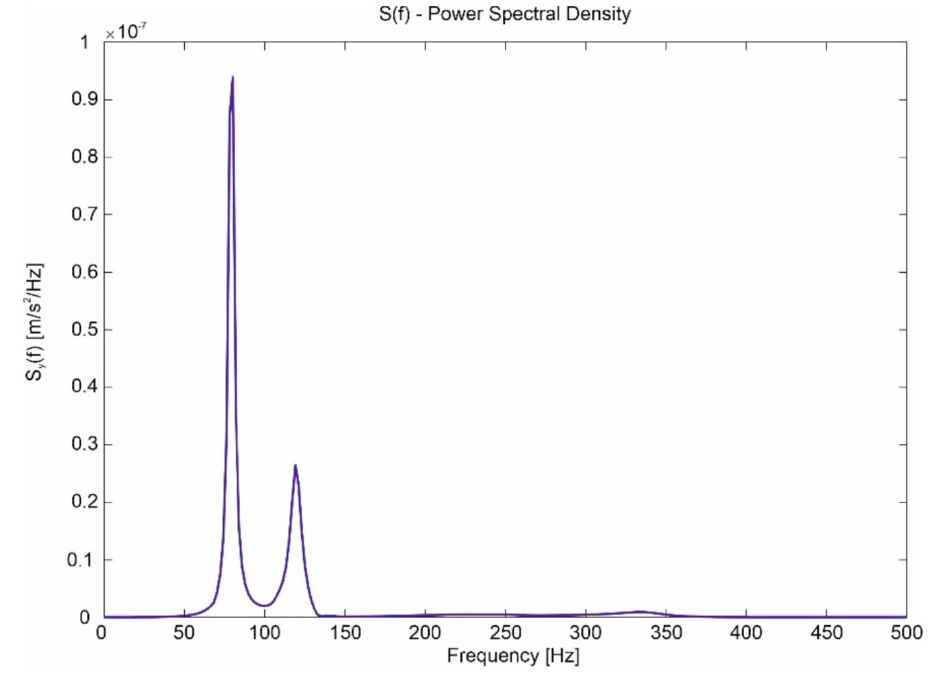
Figure28. Spectrumgeneratedfromaccelerationonthelevitationsysteminthedirection y for1000km /